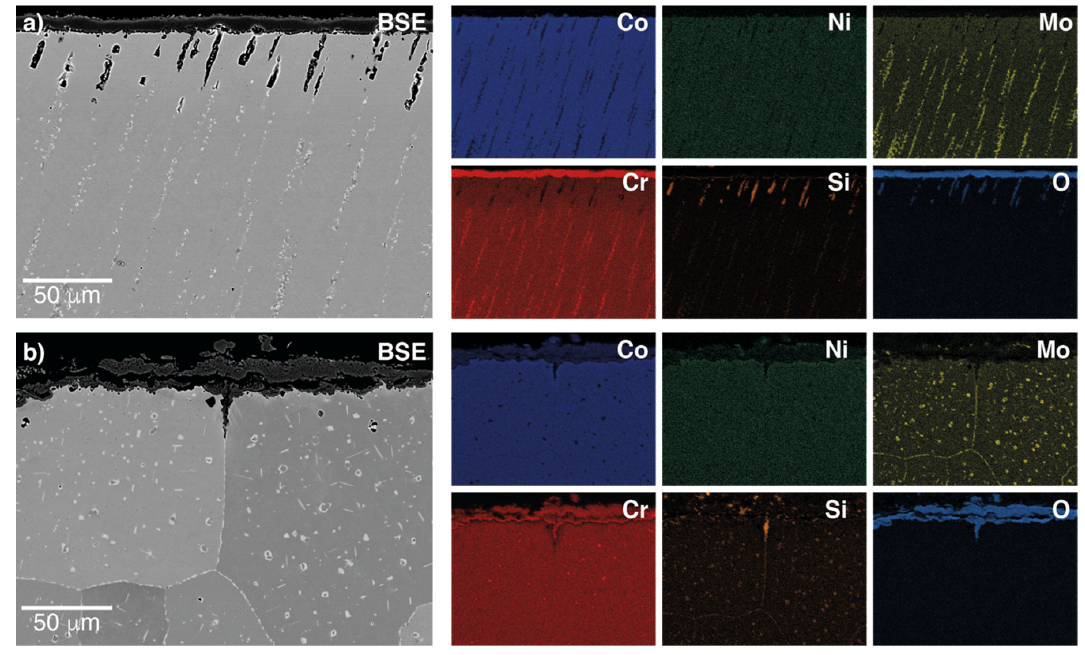
Figure 12. BSE image as well as Co, Ni, Mo, Cr, Si, and O EDX element distribution maps after 100 h oxidation at 1000 °C of ( a ) as-cast and ( b ) 1250 °C 10 h heat-treated Stellite-21.